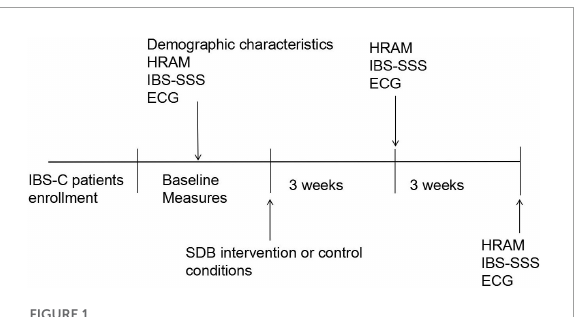
FIGURE1 The study procedure. IBS-C, irritable bowel syndrome with constipation; HRAM, high-resolution anorectal manometry; ECG, electrocardiography; IBS-SSS, irritable bowel syndrome symptom severity system; SDB, slow, deep